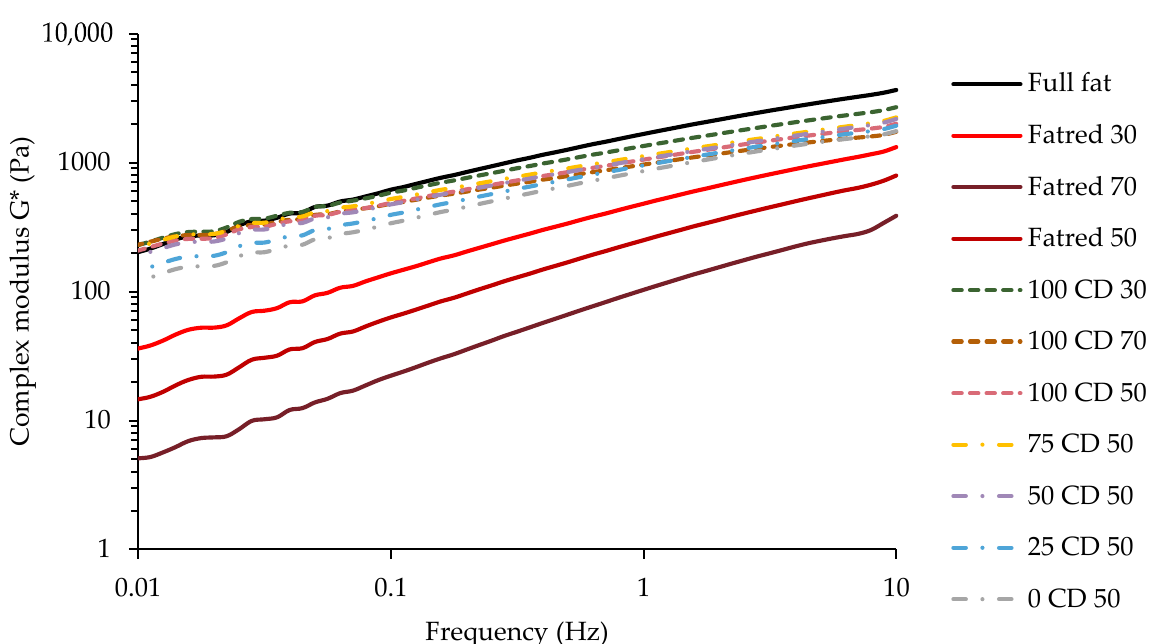
Figure A4. Force – time diagram of single measurements of all PCS formulations as example curves for the spreadability analysis.